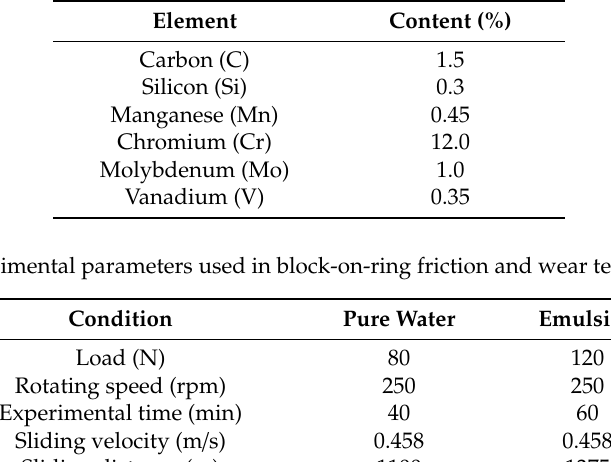
Table 1. Element compositions of SKD11 materials for block-on-ring wear tests.